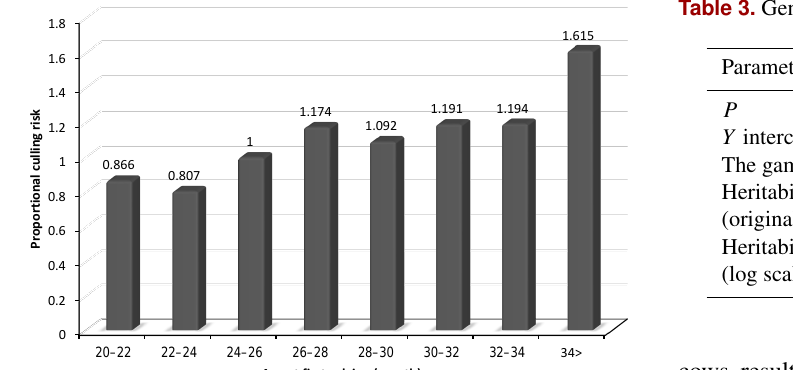
Table 3. Genetic parameters estimated for productive